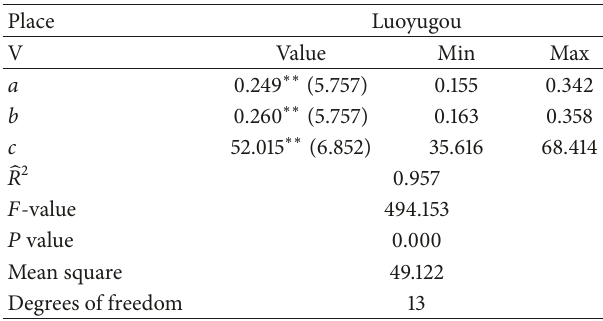
Table 13: Fitting parameters of empirical model on L-3 by sieve- pipette